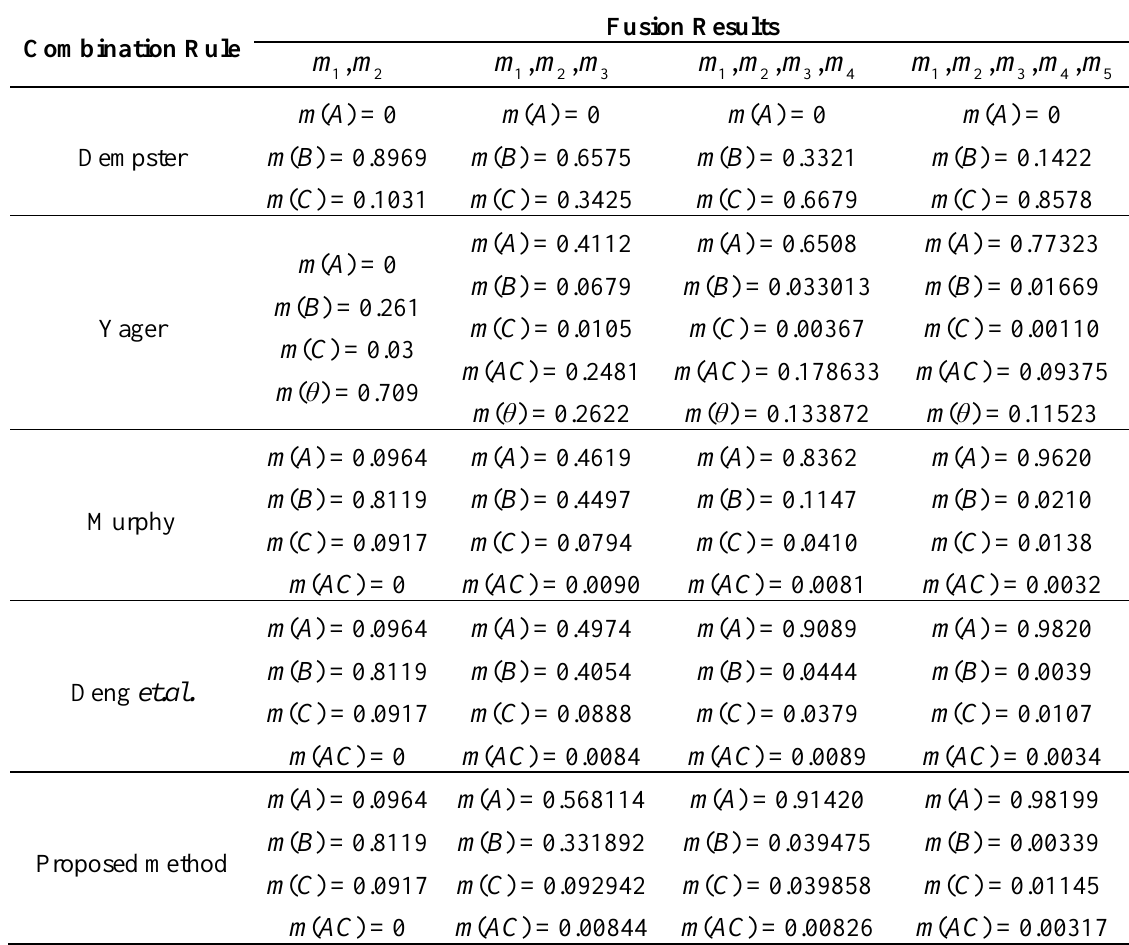
Table 2. Fusion results with different combination